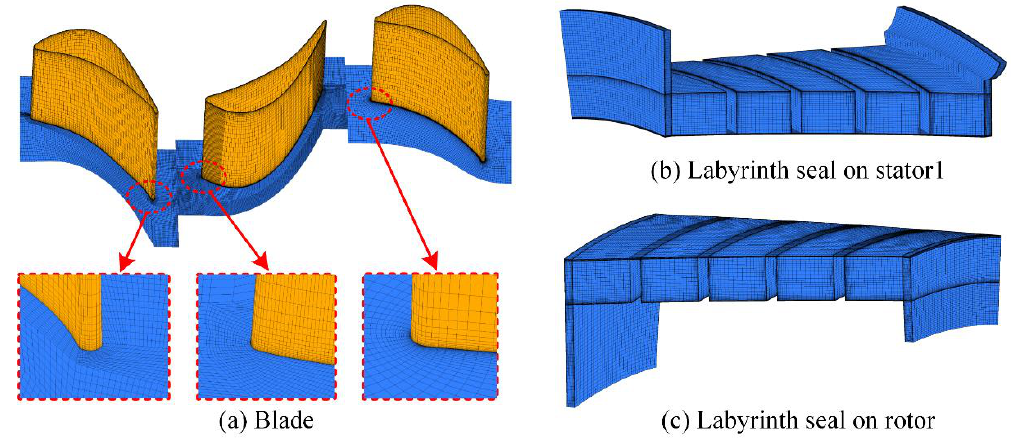
Figure 3. Computational Mesh.